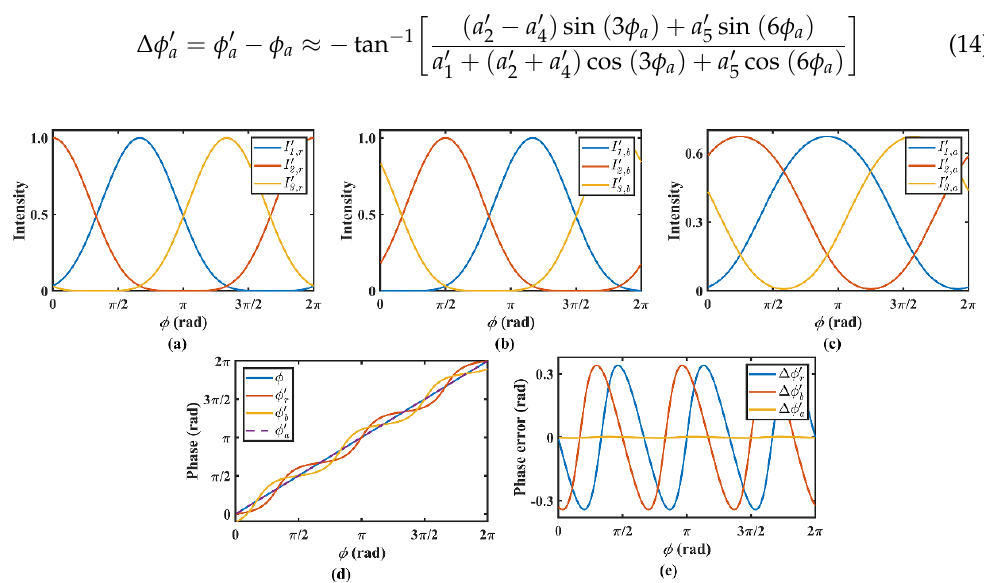
Figure 2. ( a , b ) The red and blue channels of the distorted fringe patterns when the gamma value is set to γ = 2.5; ( c ) the average fringe patterns; ( d ) the undistorted, distorted, and corrected phases, respectively; ( e ) the nonlinear phase errors.